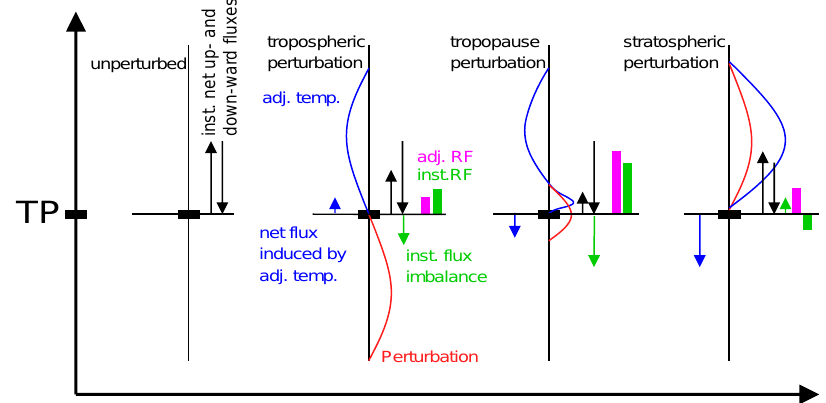
Fig. A4. Schematic of the relation between instantaneous (green bar) and adjusted RF (magenta bar) for ozone changes for four situations: unperturbed, tropospheric perturbation, tropopause perturbation and stratospheric perturbation (from left to right). The perturbation pattern is given as a red line, the instantaneous upward and downward net flux changes are given as black arrows. Net flux means the sum of longwave and shortwave fluxes. The adjusted stratospheric temperatures are shown as a blue line, and the resulting net flux changes as blue arrows. For details characterising the different cases, see the